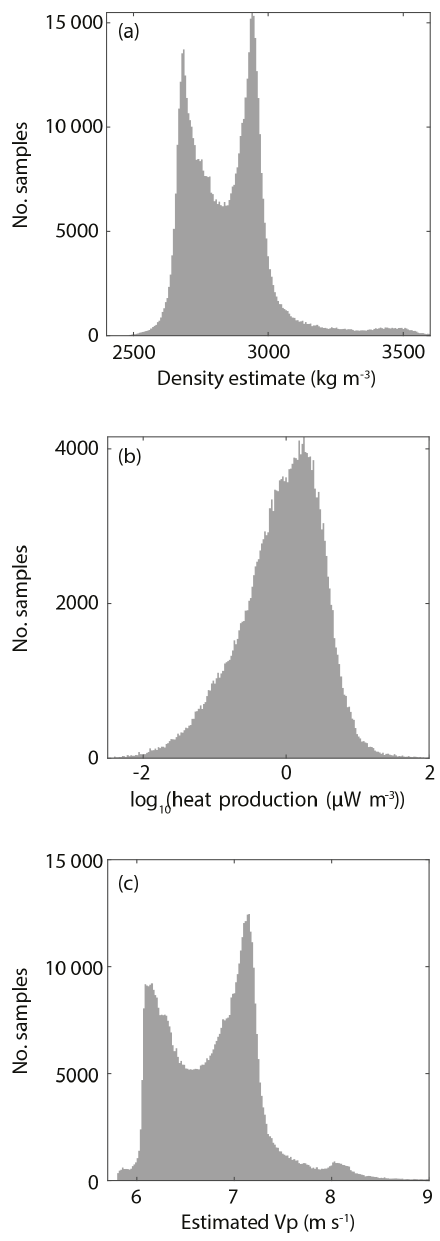
Figure 7. Example computed physical property estimate distribu- tions. (a) Density. (b) Heat production. (c) P-wave